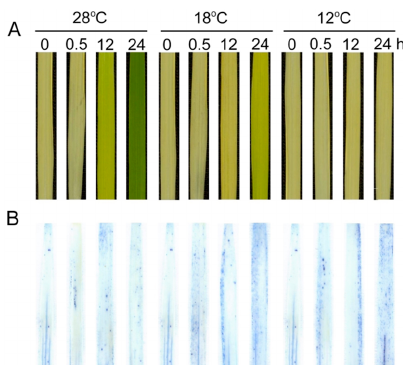
Figure 10. Effect of chilling stress on cell death of rice seedlings. Six day old etiolated seedlings were treated with 18 °C or 12 °C chilling stress. Phenotypes of rice leaves at different time points ( A ); Trypan-blue staining ( B ) of control (28 °C) and chill-stressed (18 °C and 12 °C) leaves after 0 h, 0.5 h, 12 h, and 48 h greening.